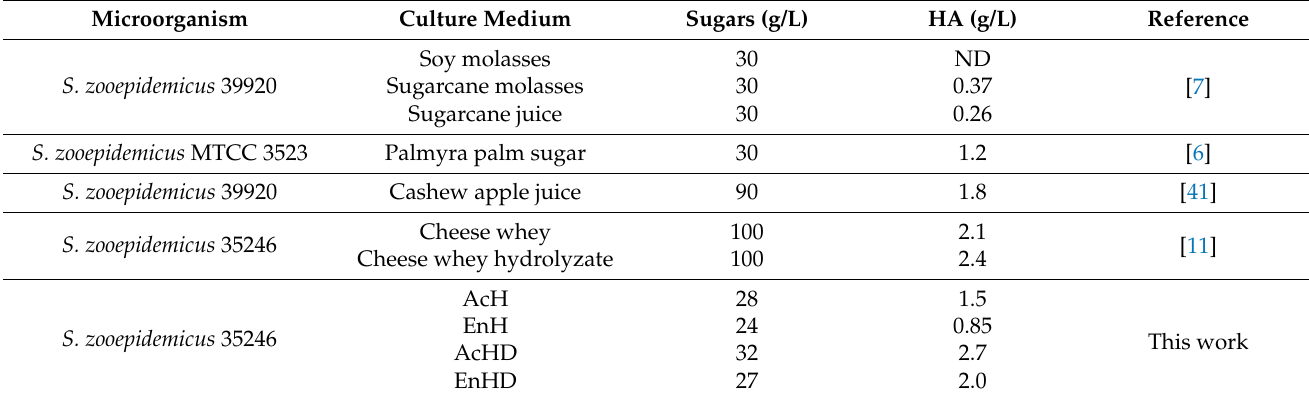
Table 6. Production of hyaluronic acid by S. zooepidemicus from alternative substrates.